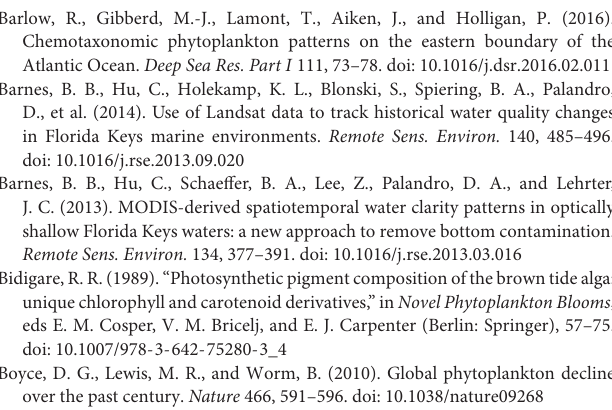
FIGURE S1 | Hierarchical cluster analysis derived from HPLC pigment ratios calculated as described in section “ HPLC Pigment and CHEMTAX Analyses” of the Methods for the March, May, and September 2016 cruises (A–C) , respectively). Main clusters are indicated with colors. Binning of the pigment data for CHEMTAX analysis was carried out according to the corresponding colored cluster. Dendrogram labels correspond to station ID’s shown in Figure 1 . FIGURE S2 | Relative abundance of phytoplankton groups derived from CHEMTAX analysis at sampled stations during March, May, and September 2016 cruises (A–C) , respectively, and combined data (D) . Dendrograms above stack plots are the same as in Figure 3 for reference. Seascape class observed at each station is shown with color bars below stack plots. Station ID’s are as in Figure 1 . Dashed rectangles highlight clustering of stations where Mesotrophic and Transition seascapes (classes 10 through 12; Table 1 ) are dominant classes. FIGURE S3 | CDOM absorption (a g ) at 443 nm measured at sampled sites during the March, May, and September 2016 cruises (A–C) , respectively. Bar plot shows average a g (443) in seascape classes 10 through 18 derived from combined data collected the during these cruises. Error bars show standard error. FIGURE S4 | Similarity matrices showing cophenetic correlation coefficients between dendrogram clusters derived from the second derivative of band-normalized phytoplankton absorption spectra [a phy ( λ )/a phy (440)] versus HPLC pigments (A–C) and seascape class (D–F) . Absorption-based dendrograms were constructed using different combinations of spectral range and then compared to dendrograms derived from HPLC pigments or seascape class data. Lower and upper limits of spectral ranges are indicated in the Y and X axis, respectively, within 10 nm bins. Left, middle, and right panels correspond to data collected during March, May, and September 2016 cruises,